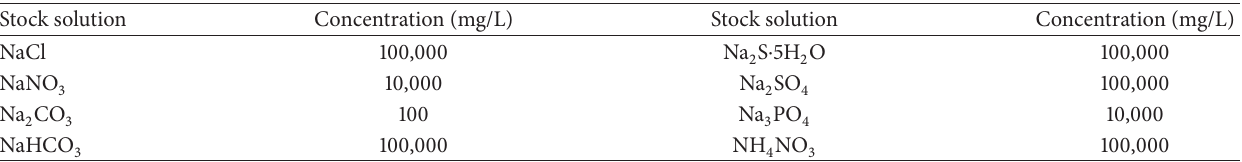
Table 3: Concentration of the prepared stock solutions.